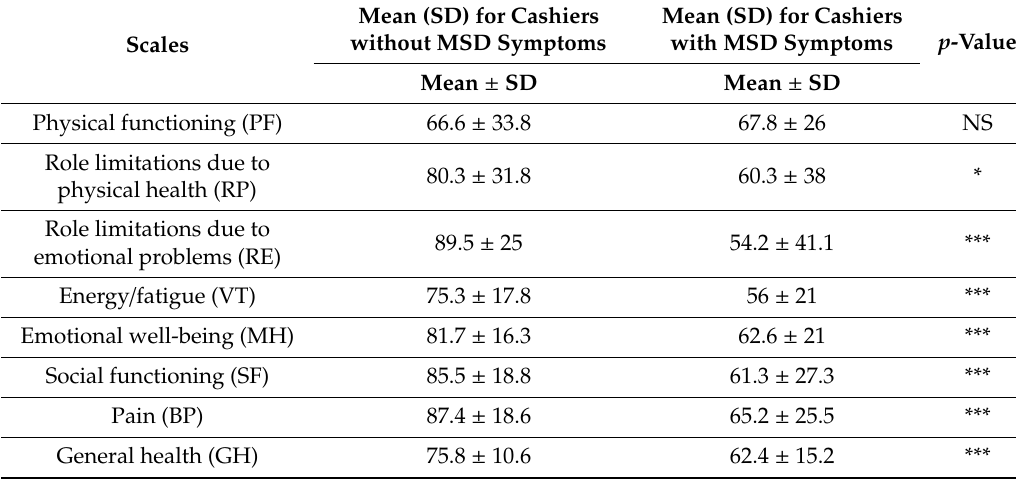
Table 5. Summary of 36-item short form (SF-36)